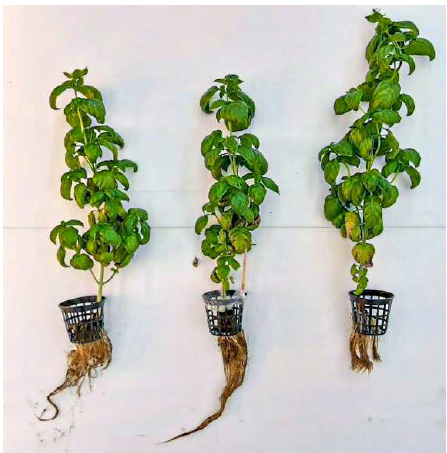
Figure 4. Average basil plants at the end of the experiment with visibly longer and finer roots and similar shoot growth performance in DRF ( left ) and raft ( middle ). Short but compact root growth and a better shoot growth performance in AERO ( right ). Shoot axis wet weight and shoot axis height differences were not significant in the DRF (12.48 g; 40.81 cm) and raft (12.22 g; 42.22 cm) and were significantly higher in AERO (17.93 g; 52.04 cm) (Figure 5). The root wet weight showed no statistical difference in the DRF (14.13 g) and AERO (15.72 g), but was significantly higher than in the raft (11.71 g). The root length was again similar in the DRF (29.58 cm) and raft (28.41 cm) and signifi- cantly longer than AERO (18.80 cm) (Figure 6). An average leaf of the third node (leaf 3) was similar in weight, length, and width for the DRF (696.83 mg; 7.31 cm; 4.81 cm) and raft (704.62 mg; 7.35 cm; 4.79 cm). AERO showed statically heavier and longer leaves in the three parameters than the other two systems (789.33 mg; 7.89 cm; 5.14 cm). The SPAD value in the DRF (37.00) and AERO (36.58) was significantly higher than in the raft (33.58).